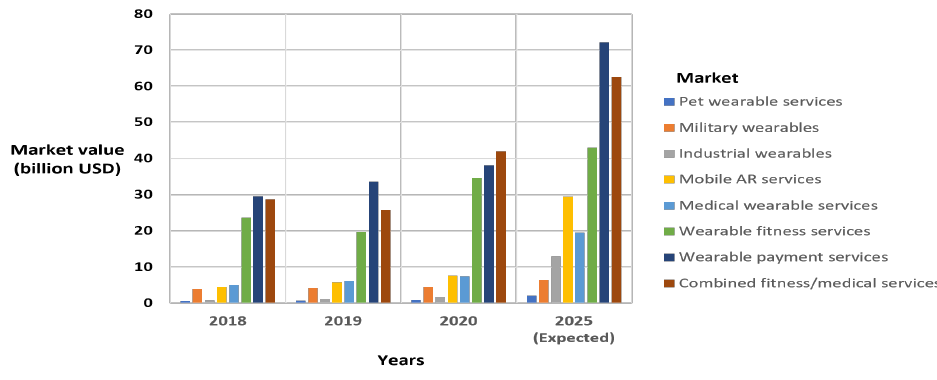
Figure 2. Wearable services market